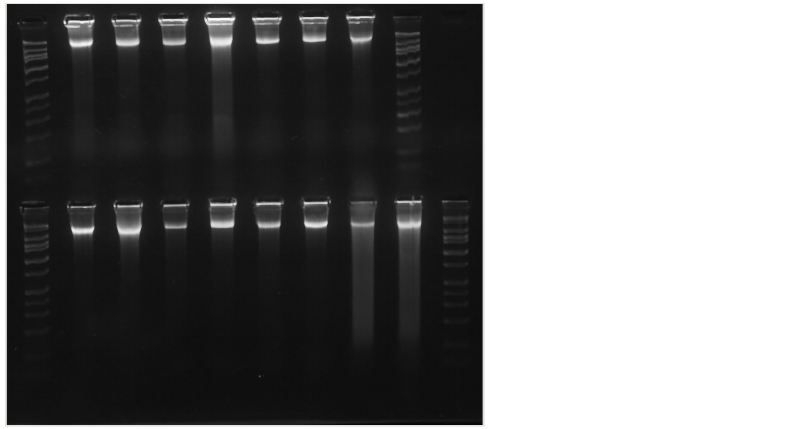
Gel image of high quality DNA (Vitaceae, ex J. Wen). DNA bands are tightly concentrated at the top of their lanes, with minimal streaking or blurring below. The HiLo gel ladder (Minnesota Molecular) at extreme left and right ranges from 50bp to 10,000bp. doi for all fi gures